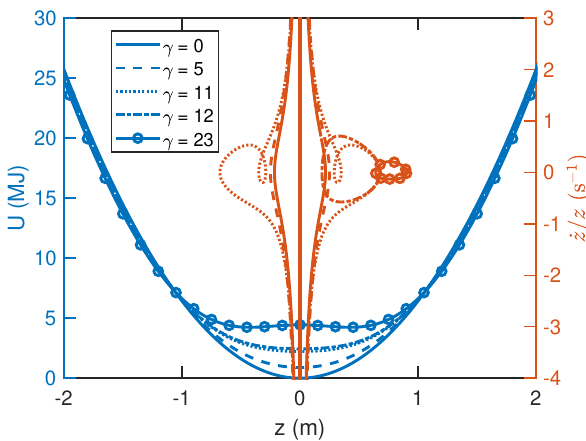
Fig. 11. The PTO potential energy profile and phase portrait of the motion when excited by ω = 1 rad / s for varying γ with the non- optimized PTO